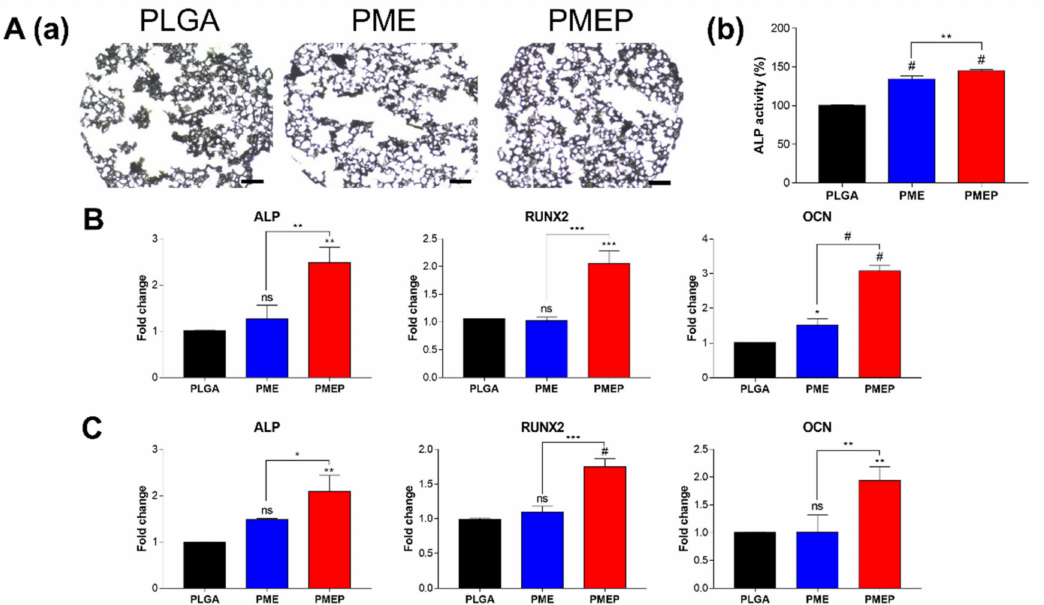
Figure 5. Osteogenic differentiation onto scaffolds using hBMSCs. ( A ) optical images of the scaffolds stained with ALP for 7 days in osteogenic medium ( a ). Scale bars indicate 400 µ m. What is more, the quantification of ALP activity onto each scaffold ( b ). ( B , C ) gene expressions of hBMSCs related to osteogenesis onto the scaffolds; ALP, RUNX2, and OCN at 7 and 21 days of osteogenic differentiation. The differences were considered significant when ns = not significant ( p ≥ 0.05), * p < 0.05, ** p < 0.01, *** p < 0.001, and # p < 0.0001 ( n ≥